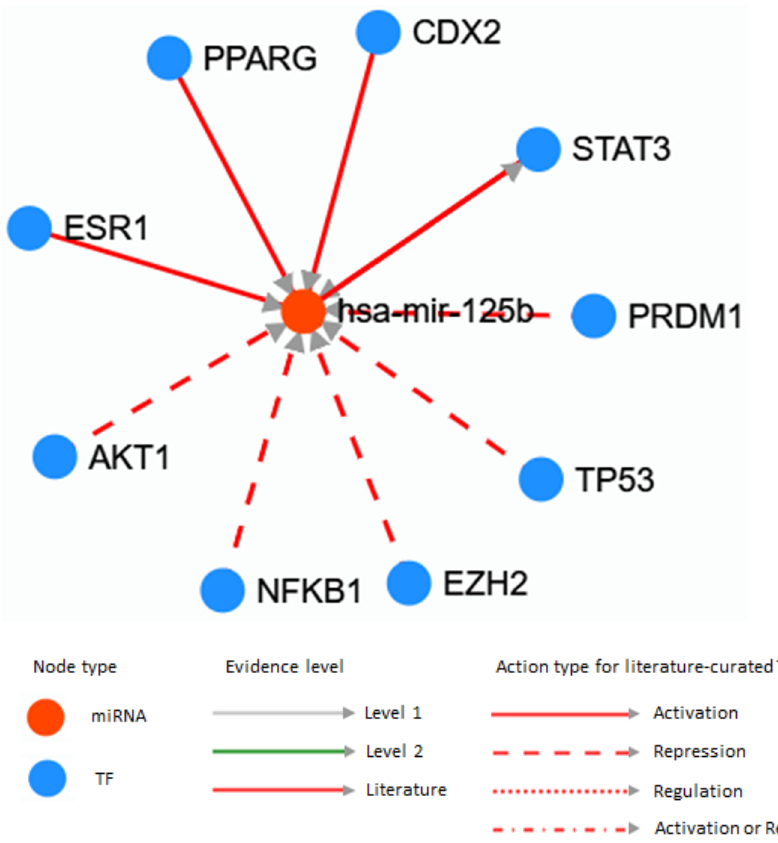
Figure 3. miR-125b and transcription factors associations (https://www.cuilab.cn/transmir; accessed on 27 January 2023). Note: level 1—regulation of TF-miRNA is associated with the analysis of a large number of microRNAs (theoretical connection); level 2—regulation of TF-miRNA is associated with the analysis of experimental